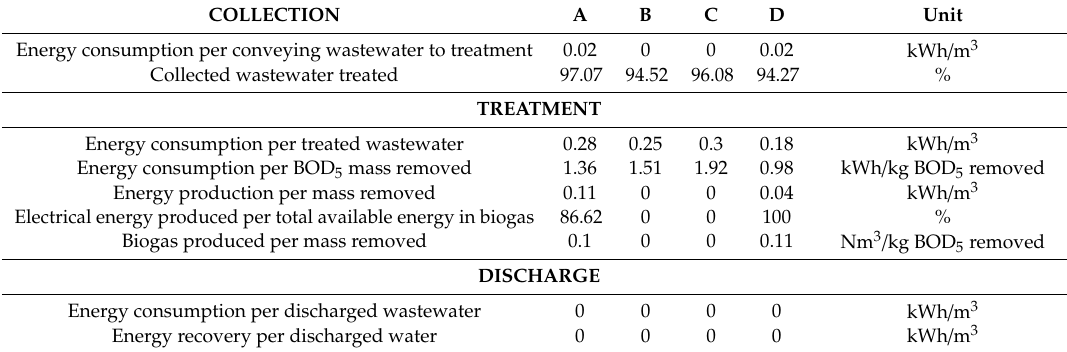
Table 5. Comparison of energy performances of the considered case studies.